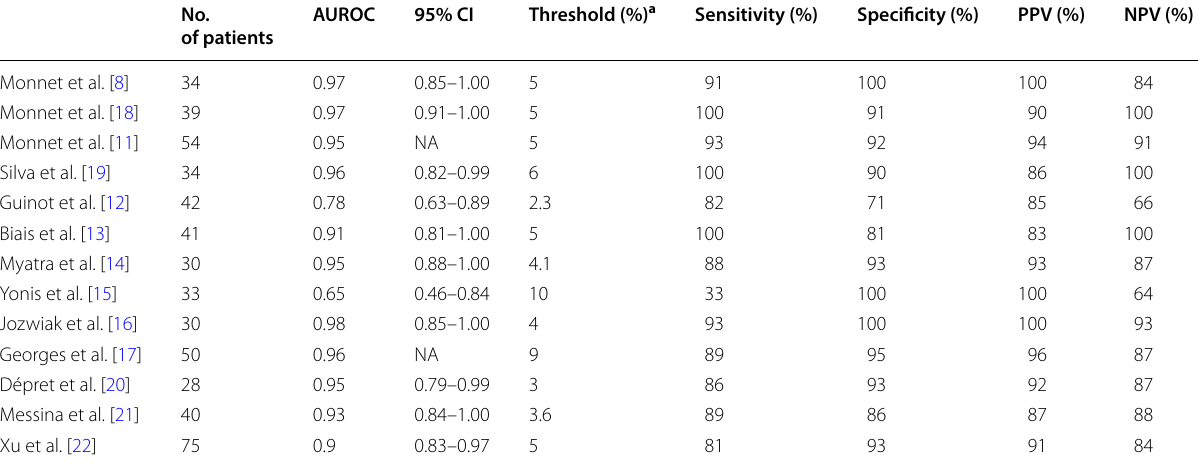
AUROC area under the receiver operating characteristic, CI confidence interval, NA not available, NPV negative predictive value, PPV positive predictive value a Threshold of increase in cardiac output induced by the test reported as providing the best compromise between sensitivity and